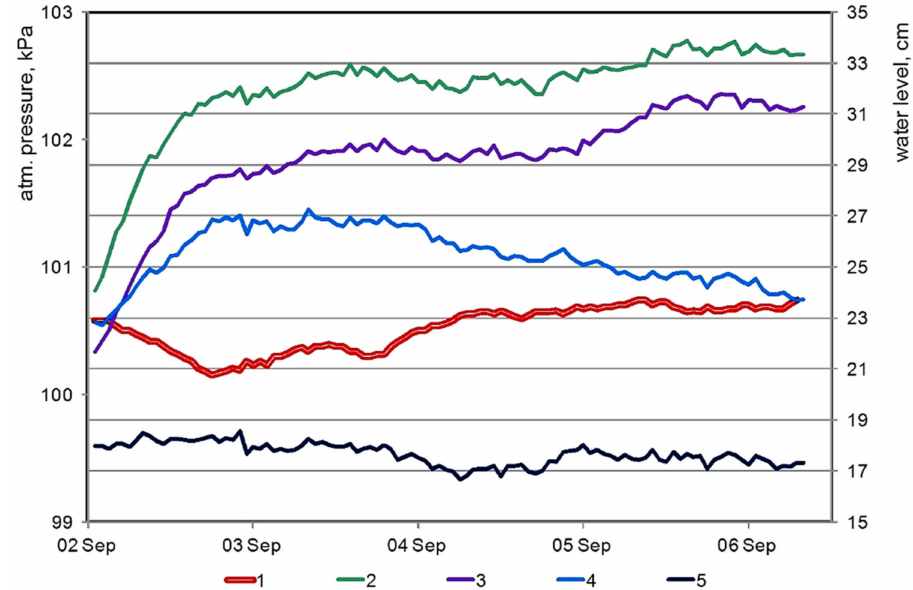
Figure 8. The suprapermafrost and surface WL dynamics and the atmospheric P changes during the second field experiment: (1) air P; WL in (2) pit No. 6, (3) pit No. 4, (4) the pit No. 5, and (5) the